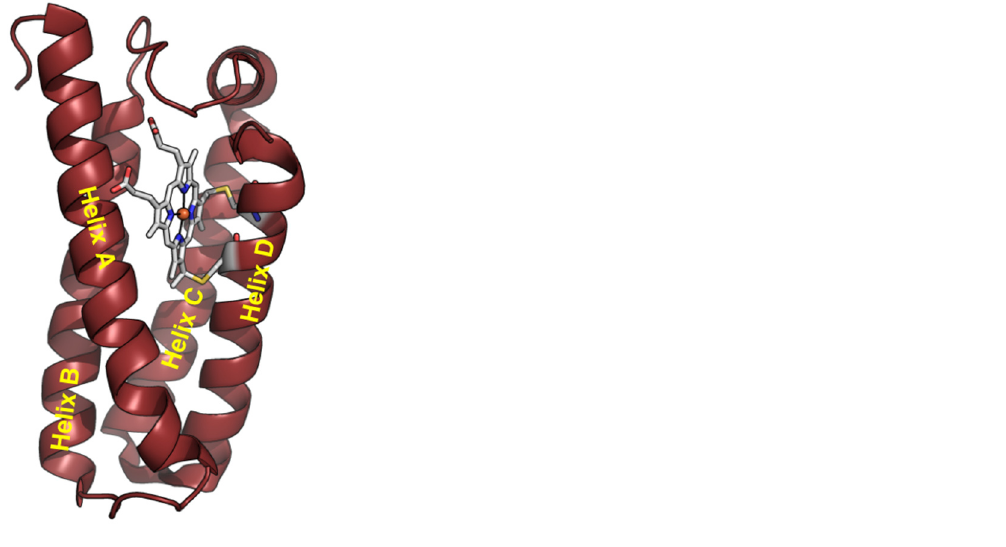
Figure 1. Structure of Cyt c ’ monomer from Alcaligenes xylosoxidans NCIMB 11015 (PDB code: 4WGZ).